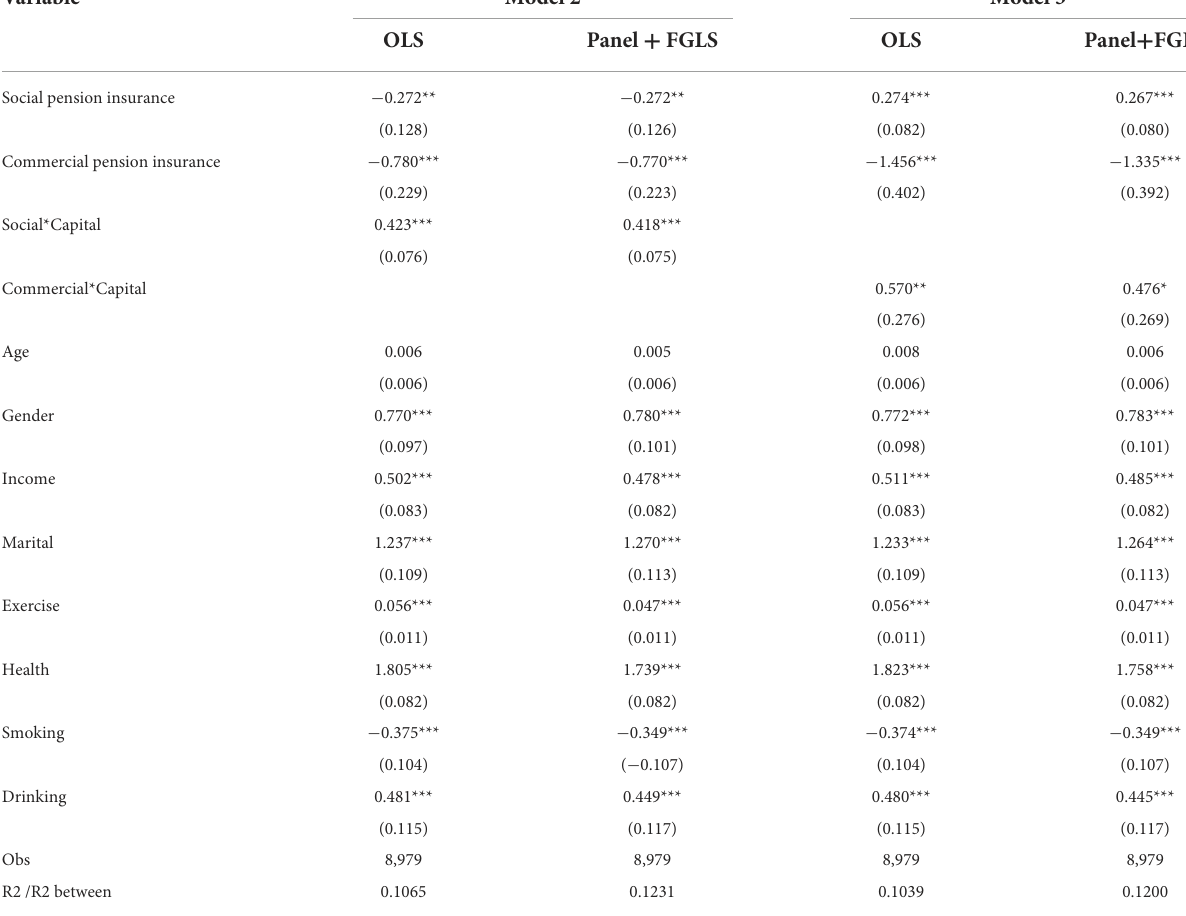
TABLE 4 Regression results of moderating